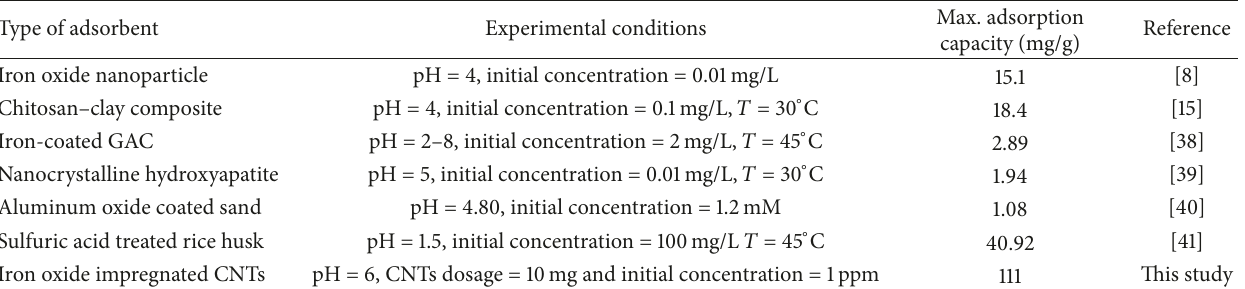
Table 3: Adsorption capacity of different materials for adsorption of selenium from water. Type of